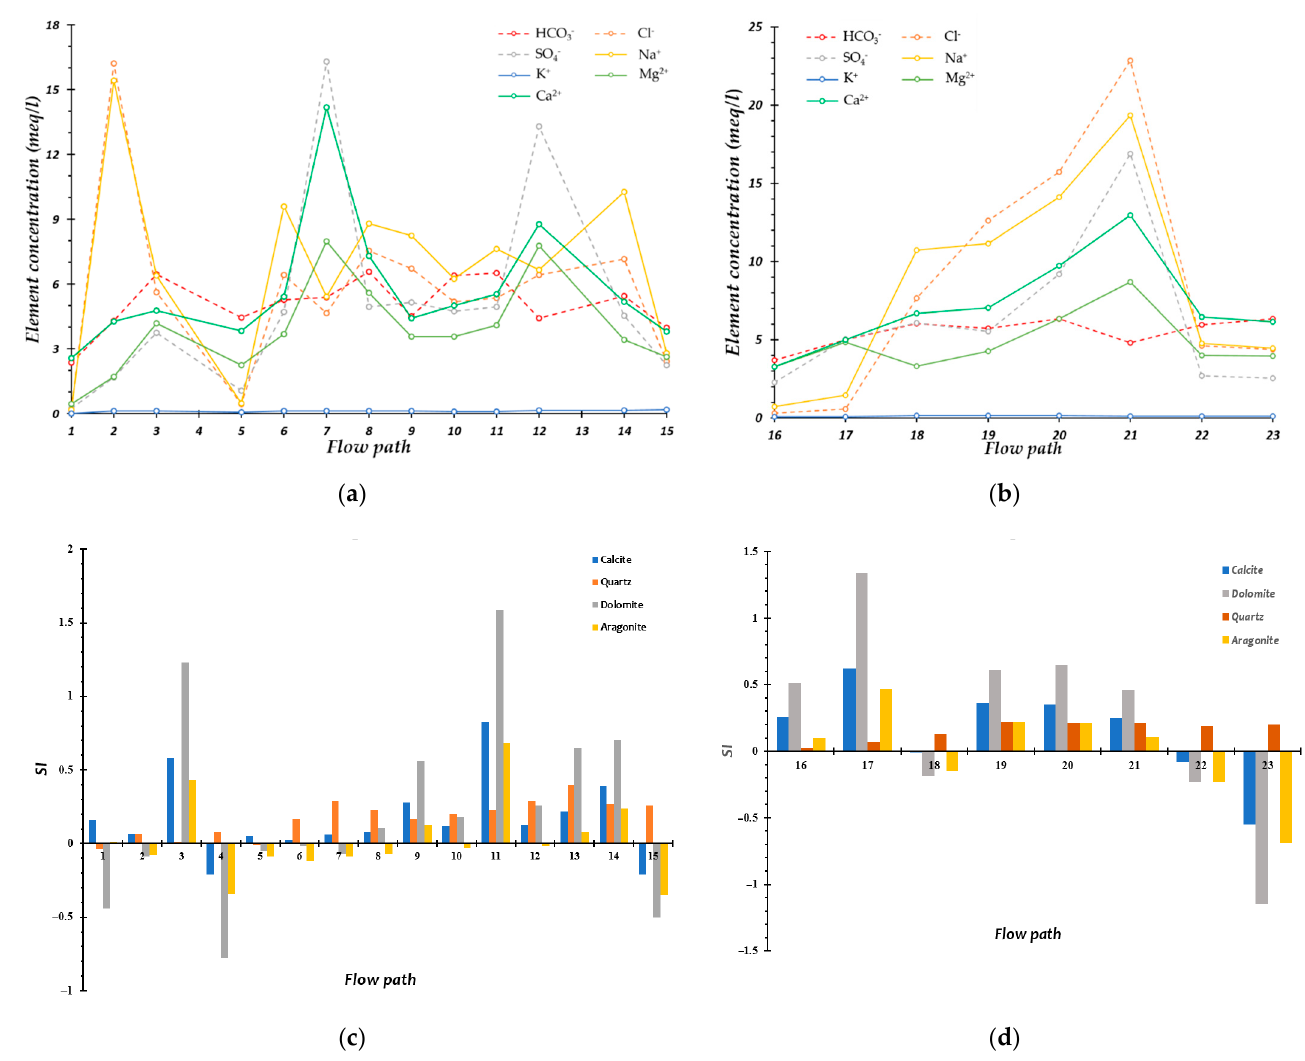
Figure 7. Plots showing the geochemical evolution during two flow paths ( a , c ) flow path A, b and d: flow path B, plots ( a , b ): the major ions evolution, plots ( c , d ) saturation index of calcite, dolomite, quartz and aragonite evolution.